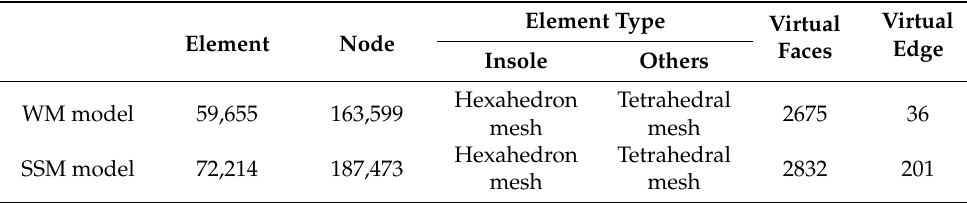
Table 1. Element types of the finite element model.